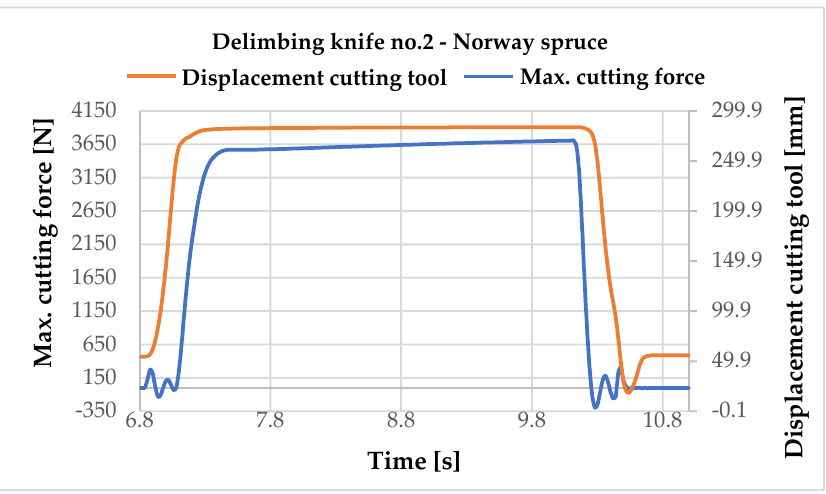
Figure 9. The course of experimental measurement of delimbing-delimbing knife No.2. The wear of the cutting edge on delimbing knife No. 3 is indicated by the color spectrum. The software accurately evaluated the place where the greatest damage occurred during the delimbing process. Changing the wear distance of the cutting edge is defined as different because the type of deformation is not the same. Delimbing knife No. 3, in terms of energy consumption with a given angular geometry, consumed the greatest force in the delimbing process (as shown in Graph 3), which led to stronger shocks and faster wear of the cutting edge. The wear demonstrated by the color spectrum shows the embossing of the worn material on the cutting edge of the delimbing knife (Figure 10. Using vector recalculations and the point method of mutual distances, the wear distance toward the material with a value of 0.2 mm on average was evaluated. The scanning of the cutting edge was performed with the 3D optical device Alicona Infinite